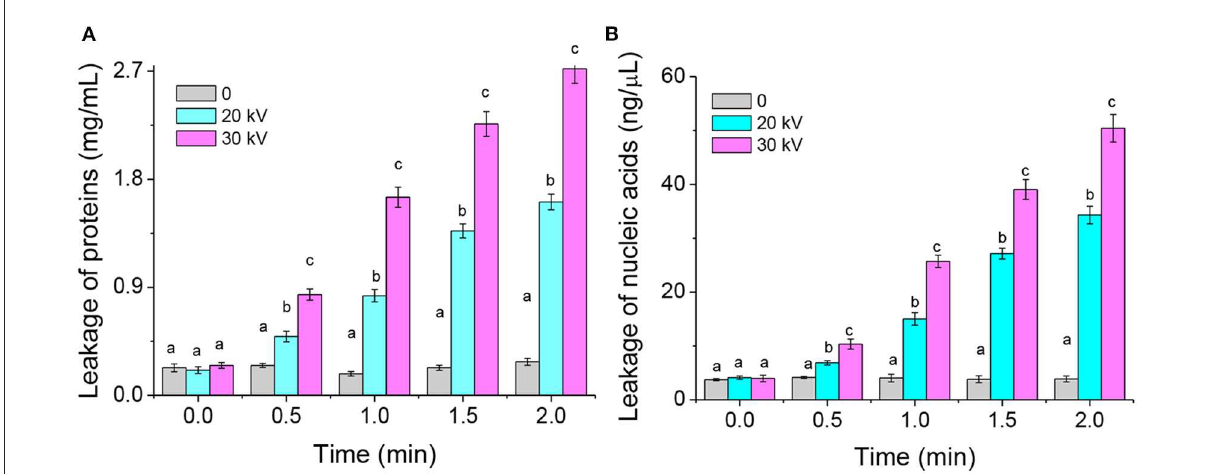
FIGURE3 Leakage of proteins (A) and nucleic acids (B) from A. acidoterrestris cells induced by DBD-ACP. Different letters (a-d) on the top of the bars denote significant differences ( p < 0.05).